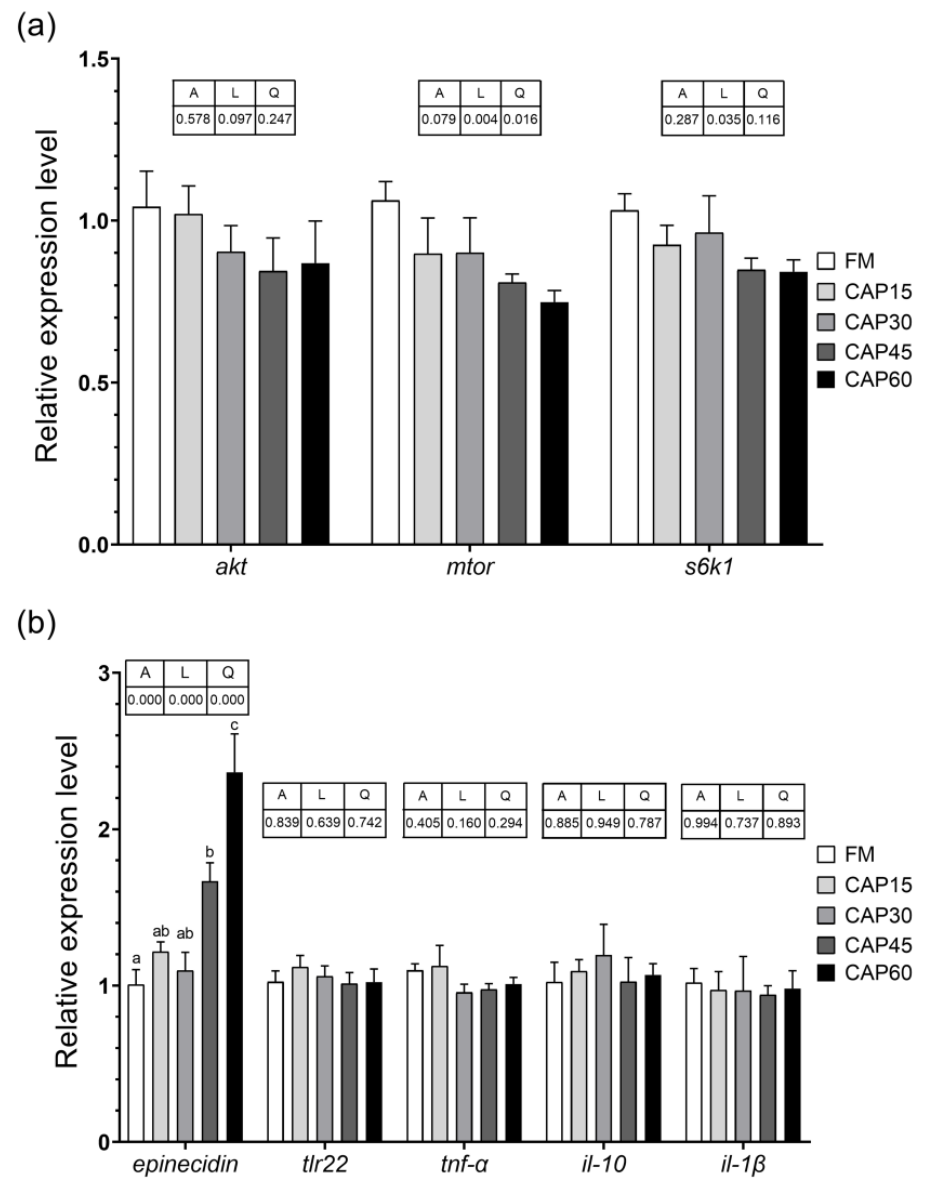
Figure 5. Relative mRNA expression level in distal intestines of pearl gentian grouper fed gradient substitution of fishmeal in the diet with CAP ( a ): mTOR signaling pathway-related genes; ( b ) Epinecidin and inflammatory factor-related genes. akt , serine/threonine-protein kinase ; mtor , mammalian target of rapamycin ; s6k1 , ribosomal protein S6 kinase 1 ; tlr22 , toll-like receptor ; tnf- α , tumor necrosis factor α ; il-10 , interleukin 10 ; il-1 β : interleukin 1 β . Bars represent means ± pooled standard error of the mean (SEM), n = 4. Different superscript letters are significantly different ( p < 0.05) among treatments. Significance probability associated with the F-statistic. A: Analysis of Variance; L: analysis of Linear trend; Q: Analysis of Quadratic trend.